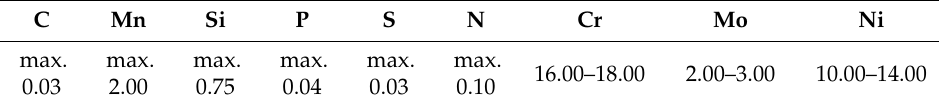
Table 1. 316L steel nominal chemical composition (weight [%]).